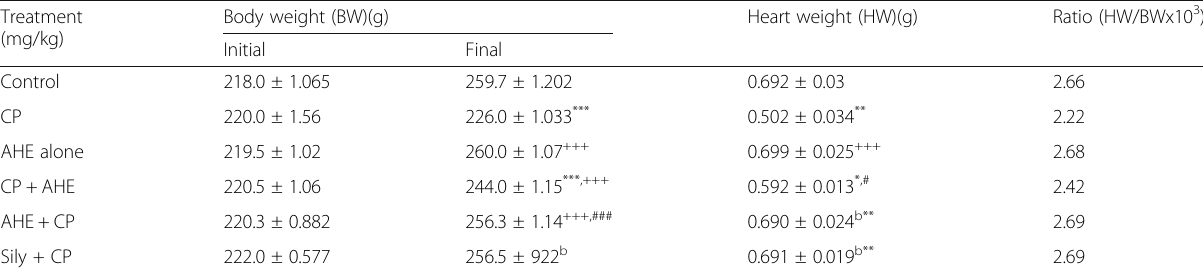
Table 2 Effect of DOX and/or AHE treatment on body weight, heart weight and heart /body weight ratio of rats Treatment